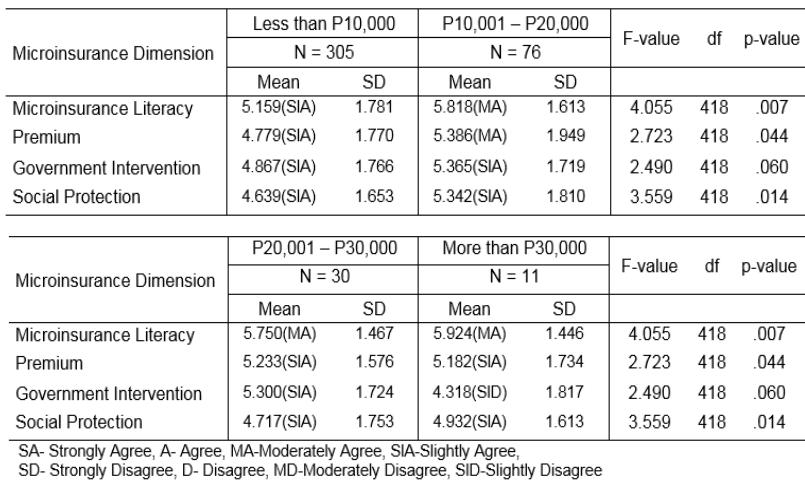
Table 11: Level of Agreement of the Respondents on the Dimensions of Microinsurance When Grouped According to Monthly